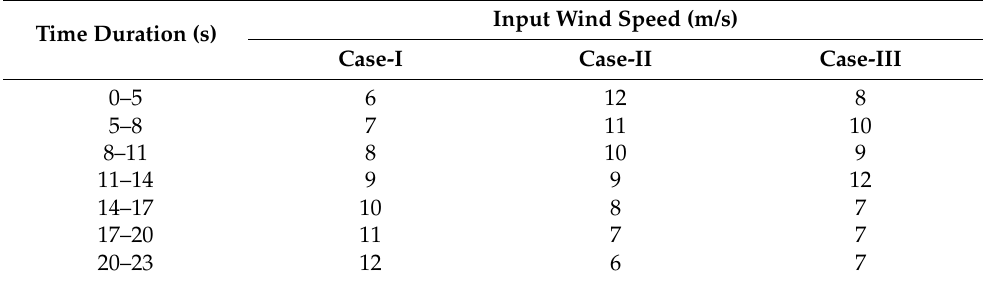
Table 7. Input wind speed in all